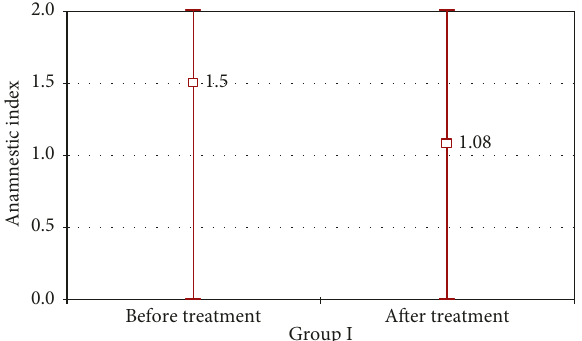
Figure 8: Average, minimal, and maximal values of AI index in group I before and after the prosthodontic therapy.